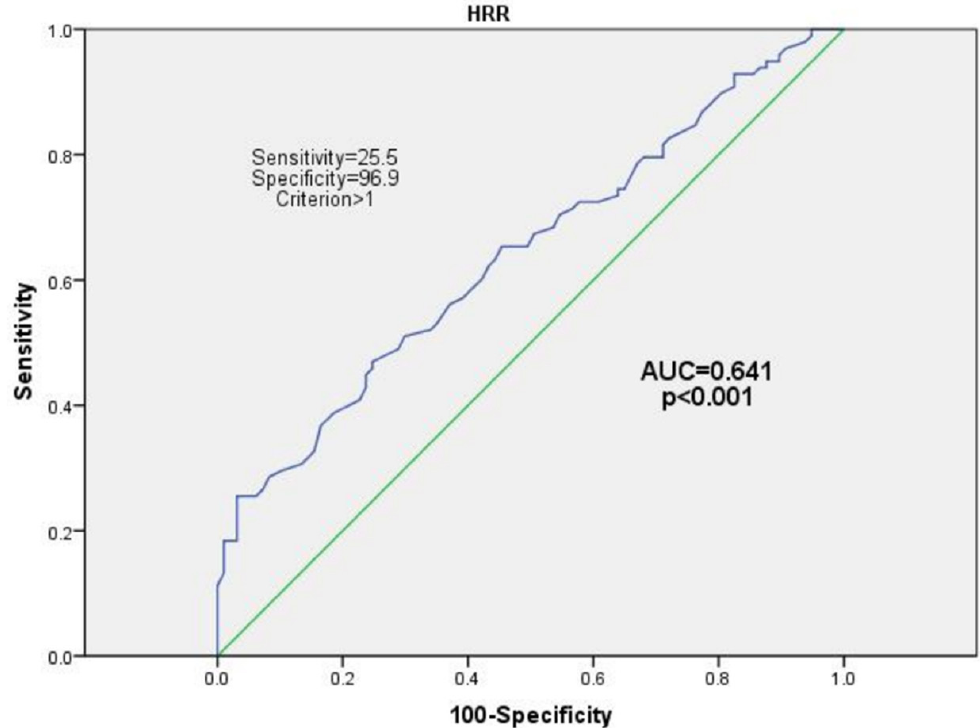
Figure 1. The optimal cutoff value to evaluate the association between CSF/plasma HRR and CNS infection was 1 [AUC 0.64; 95% CI (0.57–0.70); p < 0.001]. CSF/plasma HRR WAS dichotomized in accordance with its optimal cutoff value (1.00) and tested in multivariate logistic regression models. Multivariate Analyses between the HRR and CNS